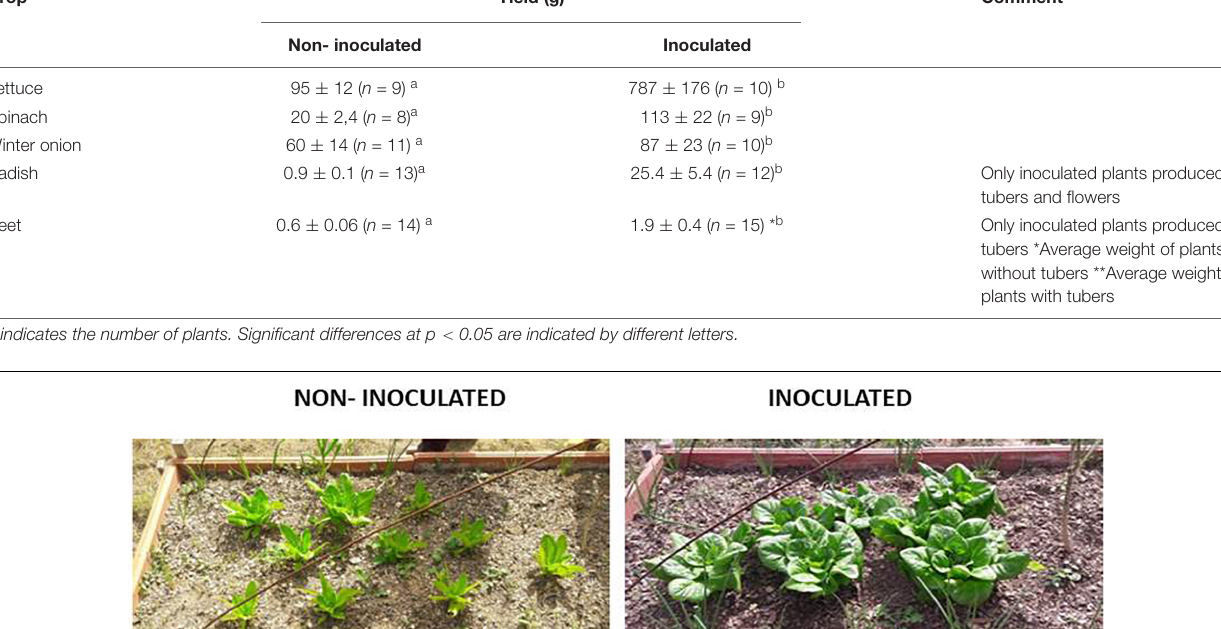
TABLE 3 | Yield of winter crops grown in an urban orchard and inoculated or not with a consortium including the bacterial strains Pantoea agglomerans RSO7, P. agglomerans RSO6, and Bacillus aryabatthai RSO25 (Paredes-Páliz et al., 2016a). Crop Yield (g)